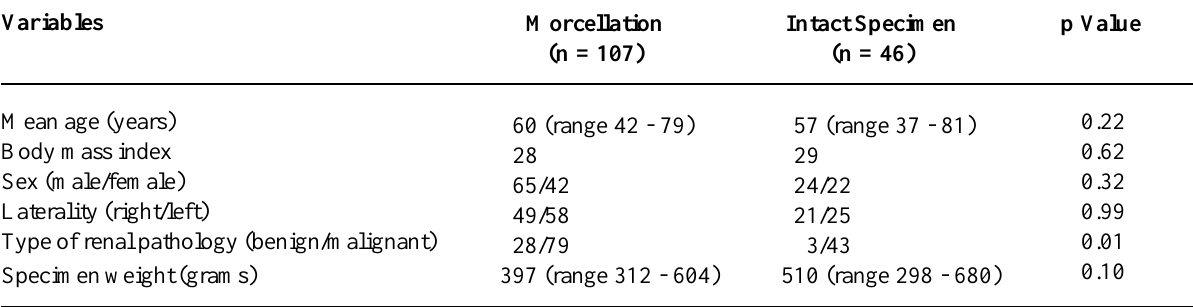
Table 1 – Patient